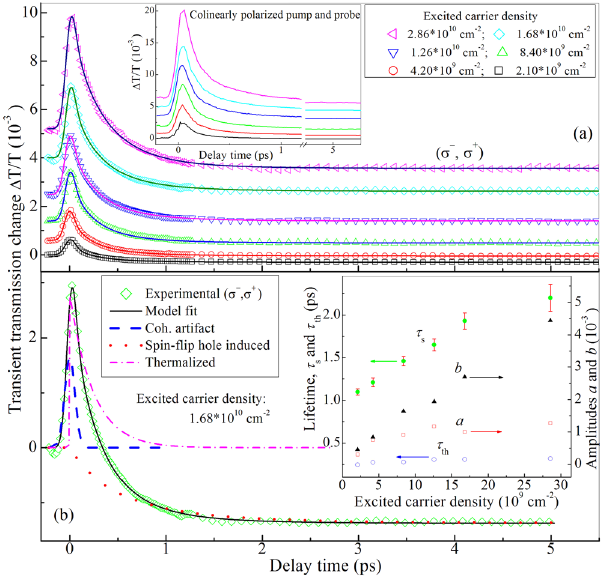
Figure 4. ( a ) ( σ − , σ + ) transient differential transmission (scattered symbols) for different excited hole density indicated in legend at room temperature. Solid lines are the best fitting to the scattered symbols with Eq. (4) in text. Inset: colinearly polarized transient differential transmission with the same excited hole density as one in ( a ) for the extraction of thermalization time τ th . ( b ) ( σ − , σ + ) transient differential transmission (scattered symbols, experimental data; solid line, best fitting) with the excited carrier density of 1.68 × 10 10 cm − 2 and its separation of three components: coherent artifact (dashed line), thermalization (dashed dot line) and spin-relaxed hole induced contribution (dot line). Inset: hole spin relaxation time τ s (filled circles) plus error bars, carrier-thermalized time τ th (open circles), the amplitudes of coherent artifact (open squares, a ) and thermalization (triangles, b ) components versus excited hole density. Errors of τ th , a and b are too less to be shown, and 5% of their values at